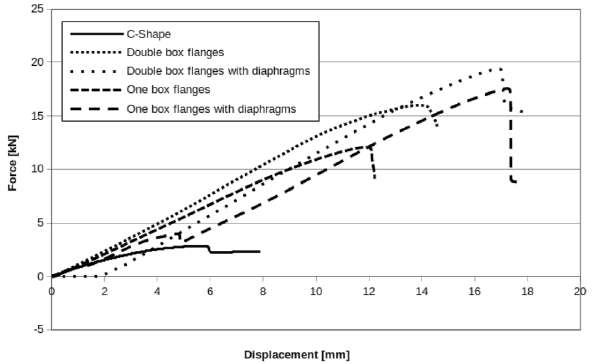
Figure 18. Displacement curve: all